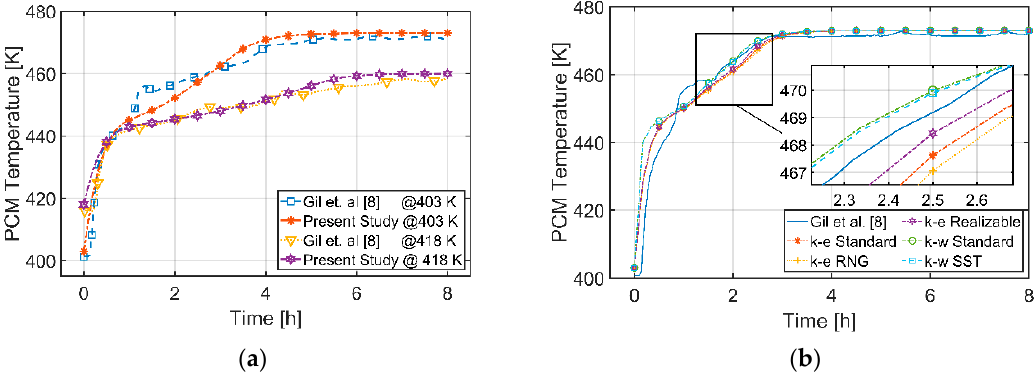
Figure 5. Validation ( a ) Laminar flow ( b ) Turbulent flow. Both flow regimes are investigated in simulated cases.